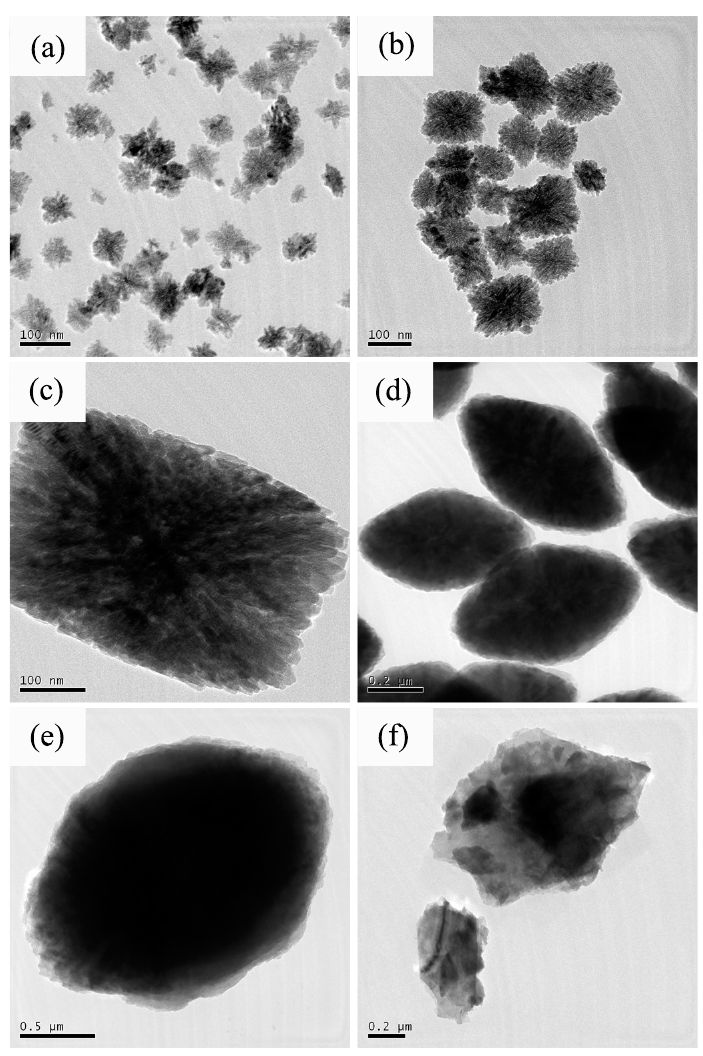
Figure 3. TEM micrographs of HT-ZrO 2 (x) particles synthesized with different concentration of NaBF 4 . ( a ) x = 0, ( b ) x = 0.005, ( c ) x = 0.01, ( d ) x = 0.02, ( e ) x = 0.03, ( f ) x =